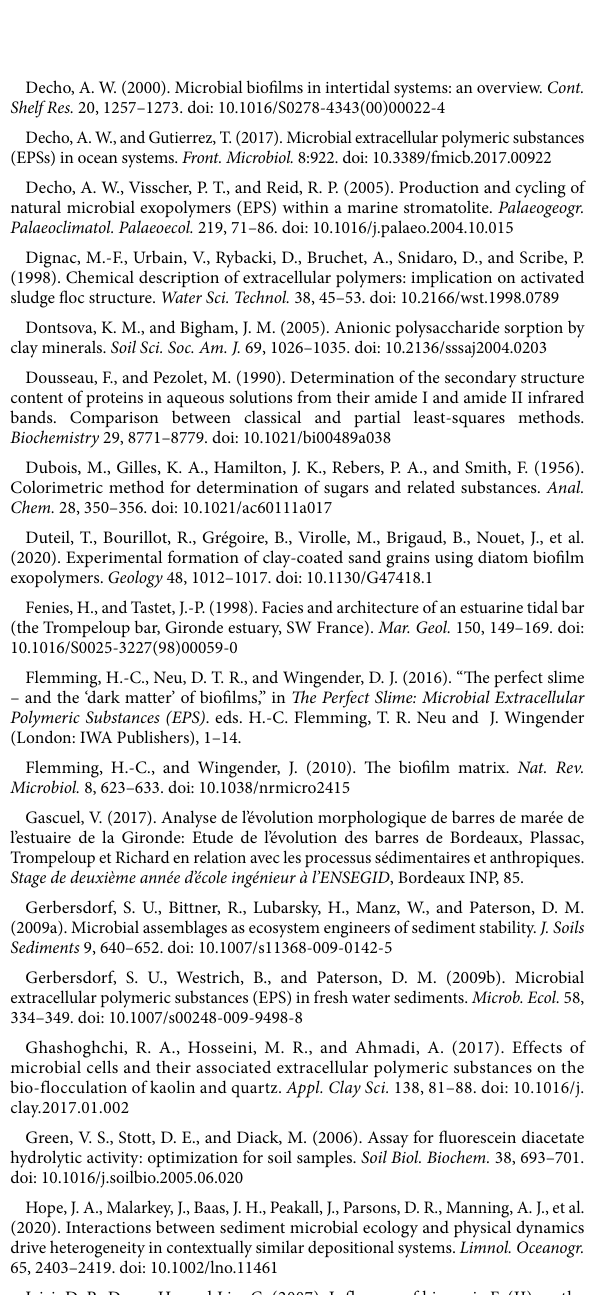
SUPPLEMENTARY FIGURE S9 Principal Components Analysis scatter plot of correlation between the samples from the BXN Long Core. Colors highlighted the main facies found in the core, facies 1 in orange, facies 2 in yellow and facies 3 in